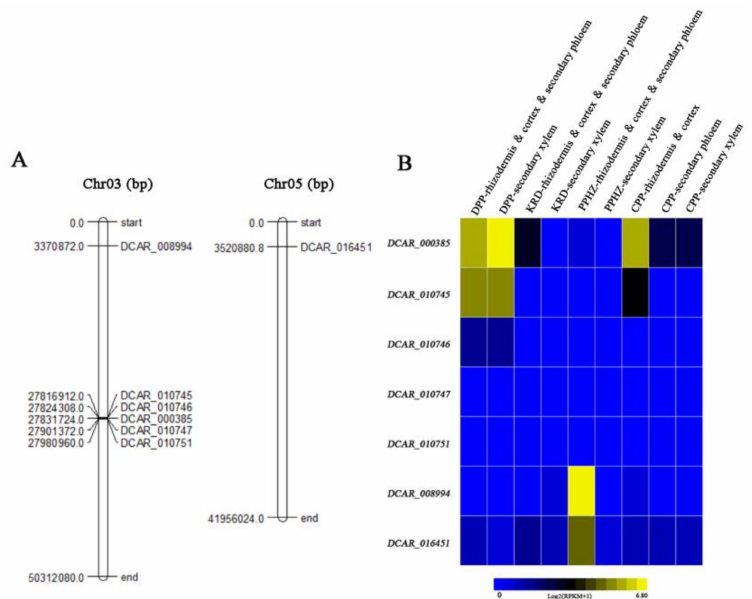
Figure 8. Site of MYB TFs in S6 subfamily on chromosome and transcript abundances of DcMYB genes in four different tissue parts of D. carota cvs. DPP, PPHZ, CPP and KRD. ( A ) represents the site of MYB TFs. Heat map was constructed based on the log2 (RPKM + 1) transformation values ( B ), and bar notes represent different expression levels. Yellow represents high expression level, and blue represents little expression